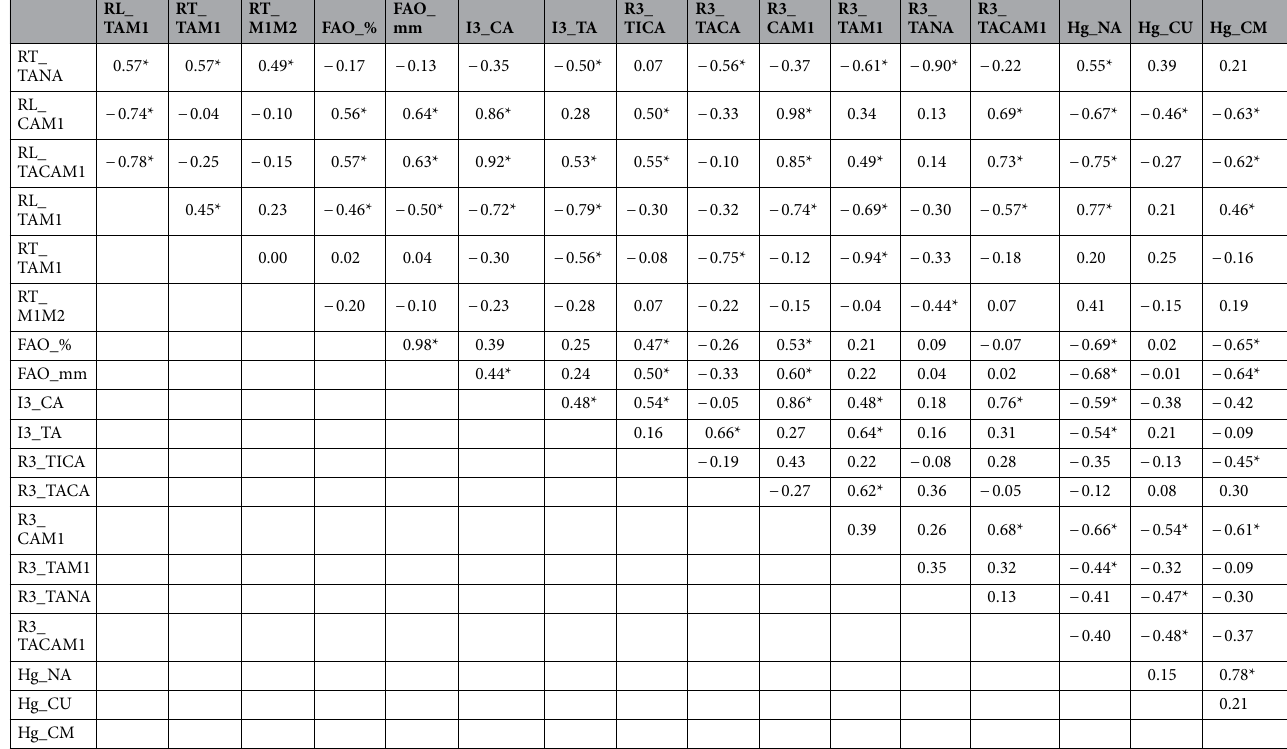
Table 3. r-values of the correlations between all measurements. Statistically significant ( p < 0.05) values are marked